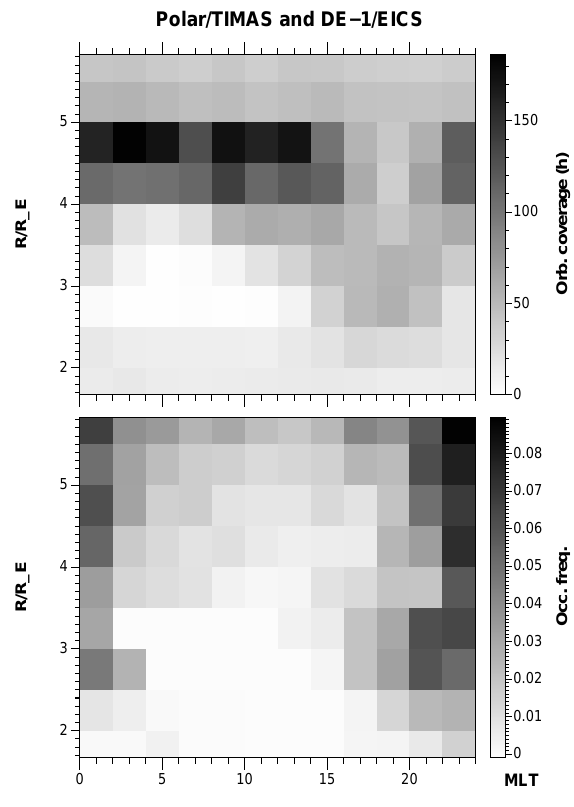
Fig. 9. Top: Orbital coverage in hours in each bin. Bottom: Occur- rence frequency of all 0.5–10keV ion beams as a function of MLT and radial distance R for all ILAT in the range 65...74. Both TIMAS and EICS data are put together, as are all K p values, with sunlit and darkness conditions. The dayside MLT range 10–14 may contain data errors and should not be looked